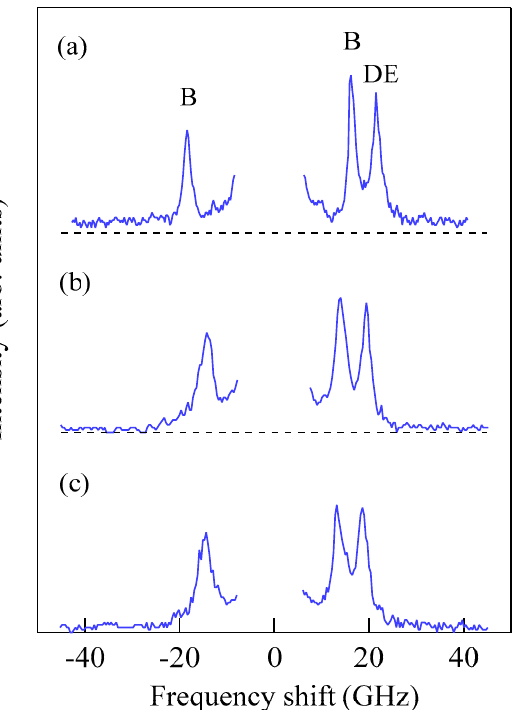
Figure 3. BLS spectra observed from ferromagnetic Co‑Al‑O nanogranular films in a magnetic field of H = 2.0 kOe. ( a ) Co 74 Al 18 O 18 , ( b ) Co 66 Al 11 O 23 , and ( c ) Co 63 Al 3 O 243 . The broken lines show the baselines of each spectrum [54].